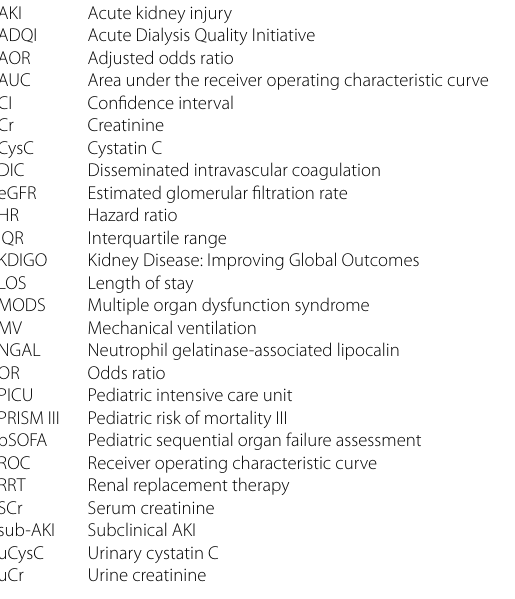
study Table S2 Comparison of demographic and clinical characteristics among AKI status Table S3. Comparison of demographic and clinical characteristics between 30-day PICU survivors and